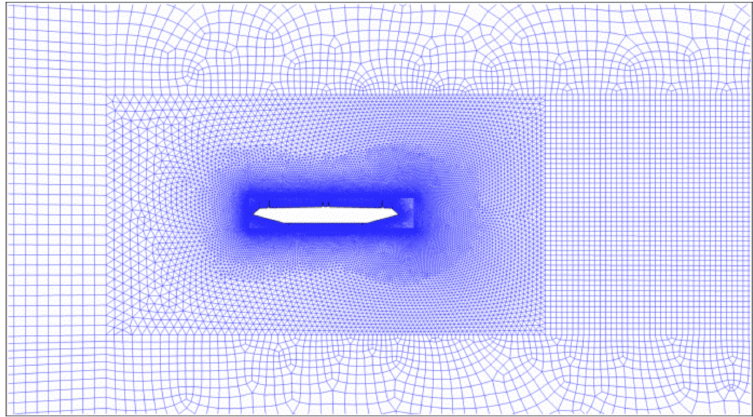
Figure 1. Computational domain sketch.